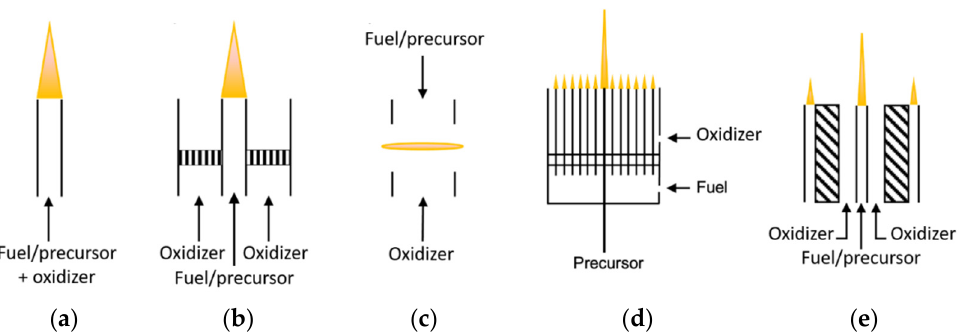
Figure 1. Flame configurations commonly used for flame synthesis process: ( a ) premixed flame, ( b ) normal diffusion flame, ( c ) counterflow diffusion flame, ( d ) multiple diffusion flames, ( e ) flame spray pyrolysis.